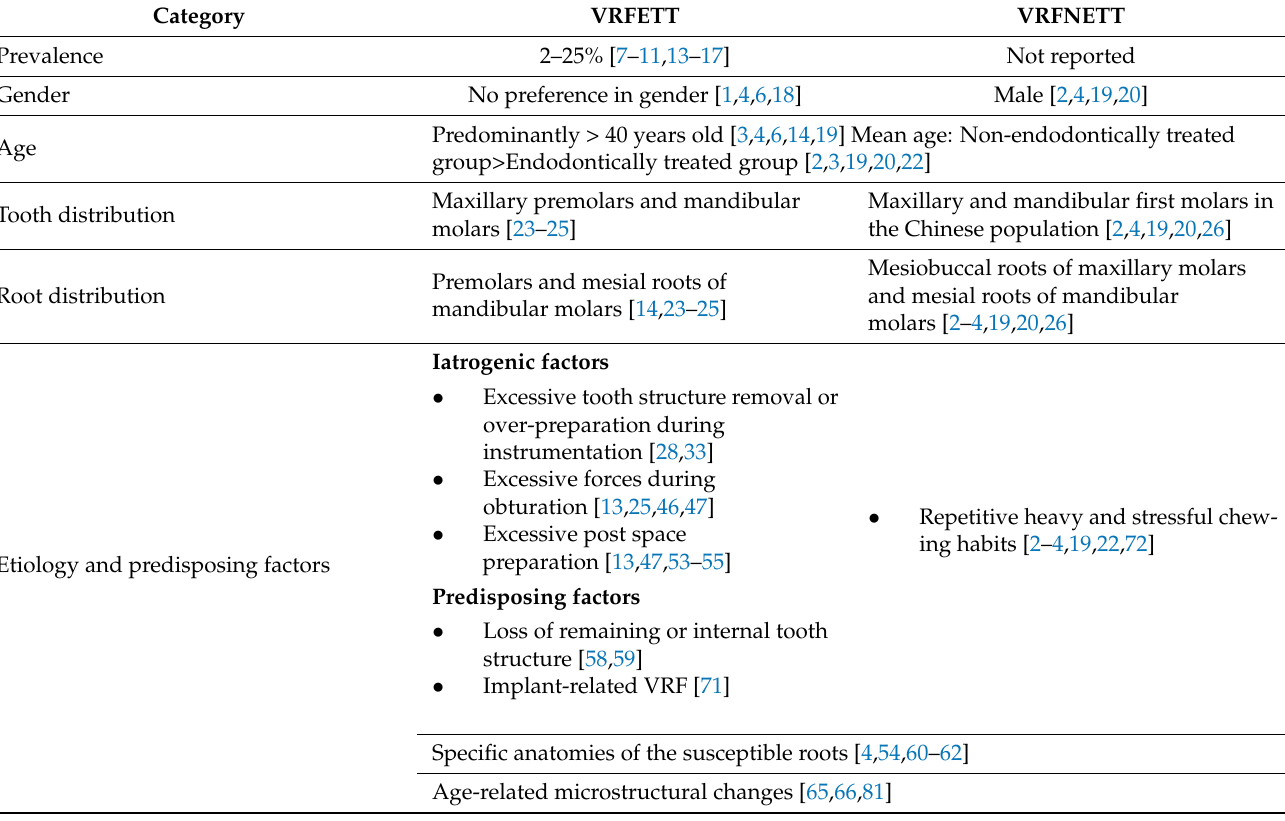
Table 3. Comparison and summary of VRFs in endodontically treated teeth (VRFETT) and VRFs in non-endodontically treated teeth